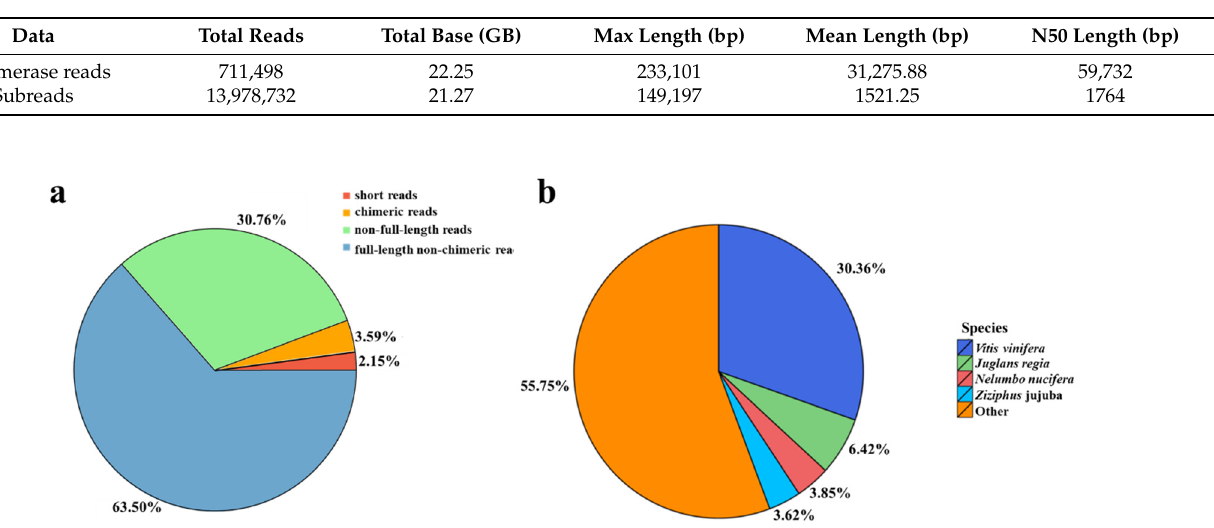
Table 1. Statistics of full-length transcriptome sequencing data.